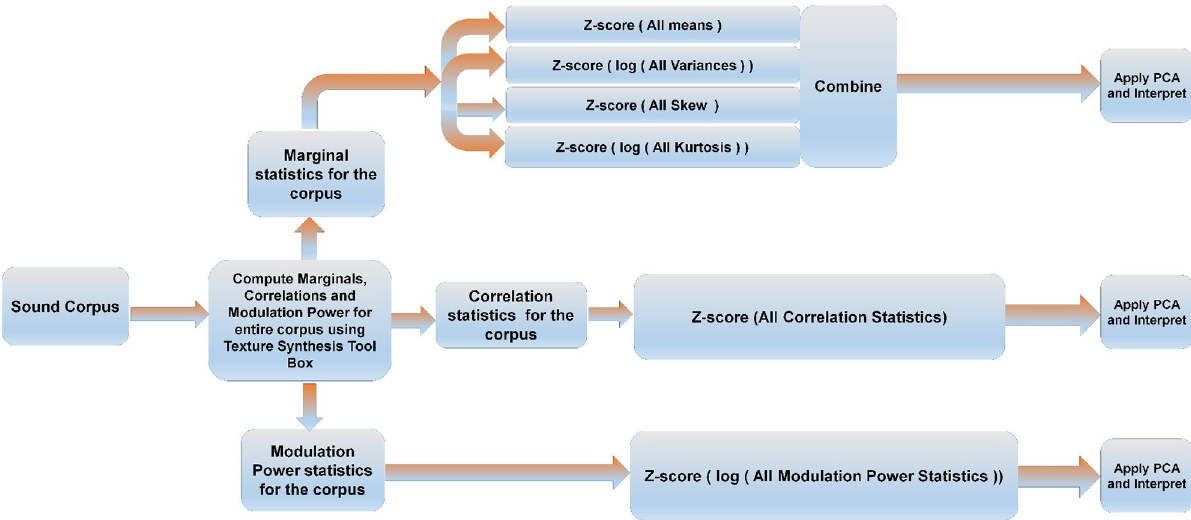
Fig 1. Work flow for exploring the statistical parameter space of a corpus of natural sounds. Using the sound synthesis tool box, marginal, correlation and modulation power statistics were computed for the entire corpus. Envelope variance and kurtosis, as well as modulation power parameters, are log transformed to make their distributions more symmetric around the mean. Each of these parameter sets is normalized and centered by z-scoring, and the z-scored parameter sets are subjected to PCA and interpreted.